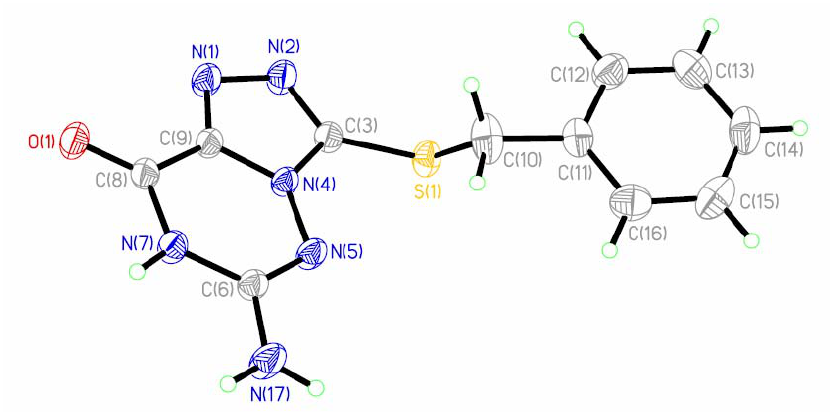
Figure 1. ORTEP drawing and atom labelling scheme of the compound 4 with thermal ellipsoids drawn at the 50% probability